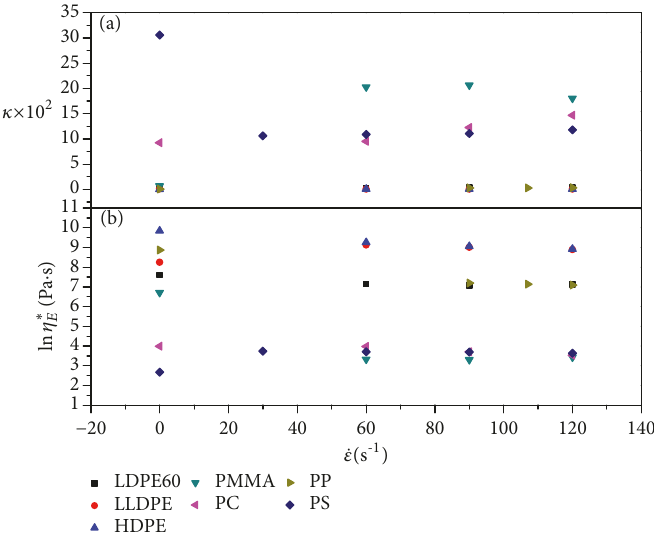
Figure 9: The elongational rate dependency of computed 𝜅 and ln 𝜂 ∗ 𝐸 calculated by (7) and (8).